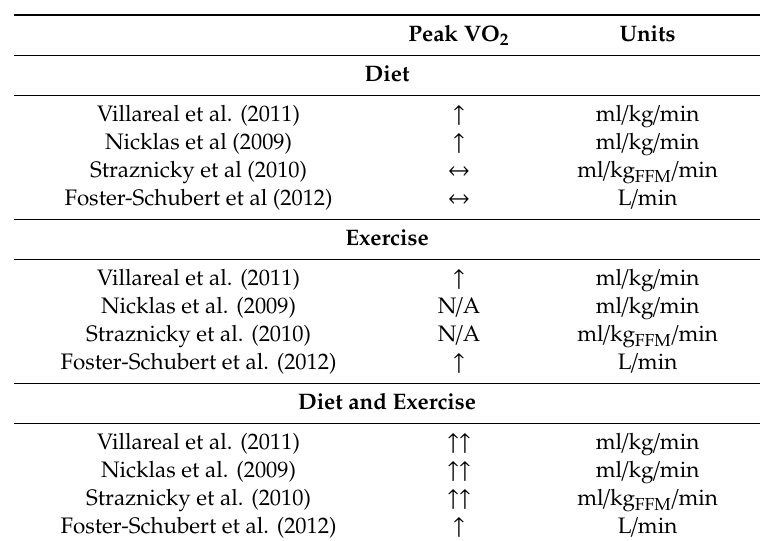
Table 2. Comparison between diet, exercise, and diet and exercise combined in published randomized controlledtrials. Thecombinationofhypocaloricdiet(HCD)andexercisetraining(ET)hasdemonstrated more consistent improvements in peak oxygen consumption (VO 2 ) than ET or diet alone